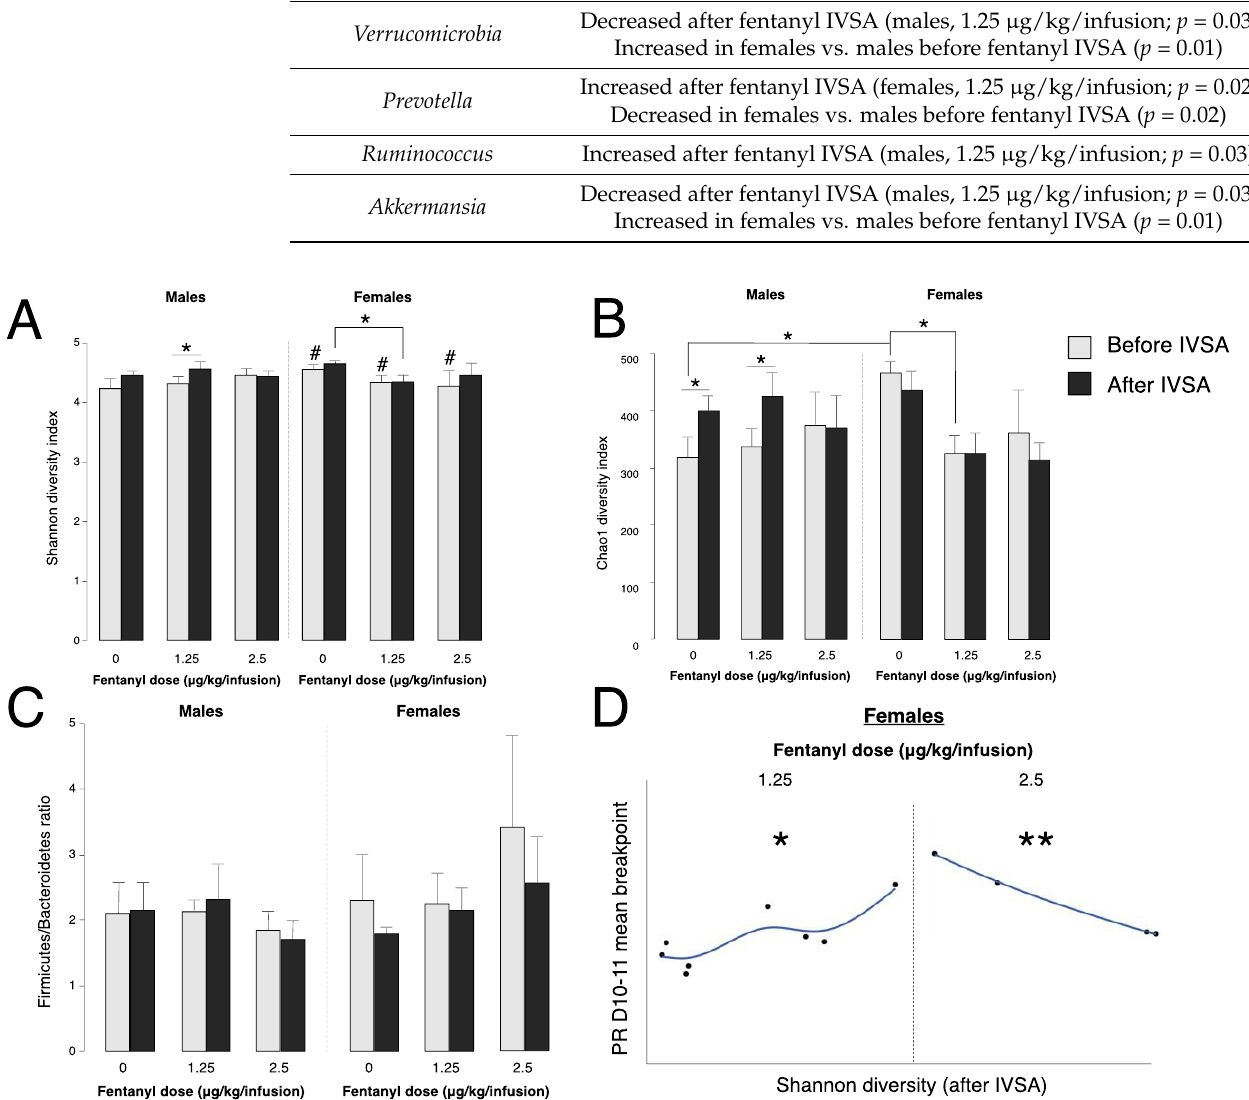
Figure 3. Alpha diversity of gut bacteria before and after IVSA. ( A ) Shannon diversity index values of gut bacteria before (gray bars) and after (black bars) IVSA in males and females (error bars represent S.E.M., * p < 0.05, # p < 0.05 vs. males, n = 4 – 9/group). ( B ) Chao1 diversity index values of gut bacteria before (gray bars) and after (black bars) in males and females (error bars represent S.E.M., * p < 0.05, n = 4 – 9/group). ( C ) Firmicutes/Bacteroidetes ratios before (gray bars) and after (black bars) IVSA in males and females (error bars represent S.E.M., n = 4 – 9/group). ( D ) Correlation plots of alpha diversity after IVSA vs. progressive ratio (PR) mean breakpoint on days (D) 10 – 11 in females at 1.25 and 2.5 μg/kg/infusion (** p < 0.01, * p < 0.05, n = 4 – 8/group). Table 2. Bacterial groups impacted by fentanyl intravenous self-administration (IVSA).